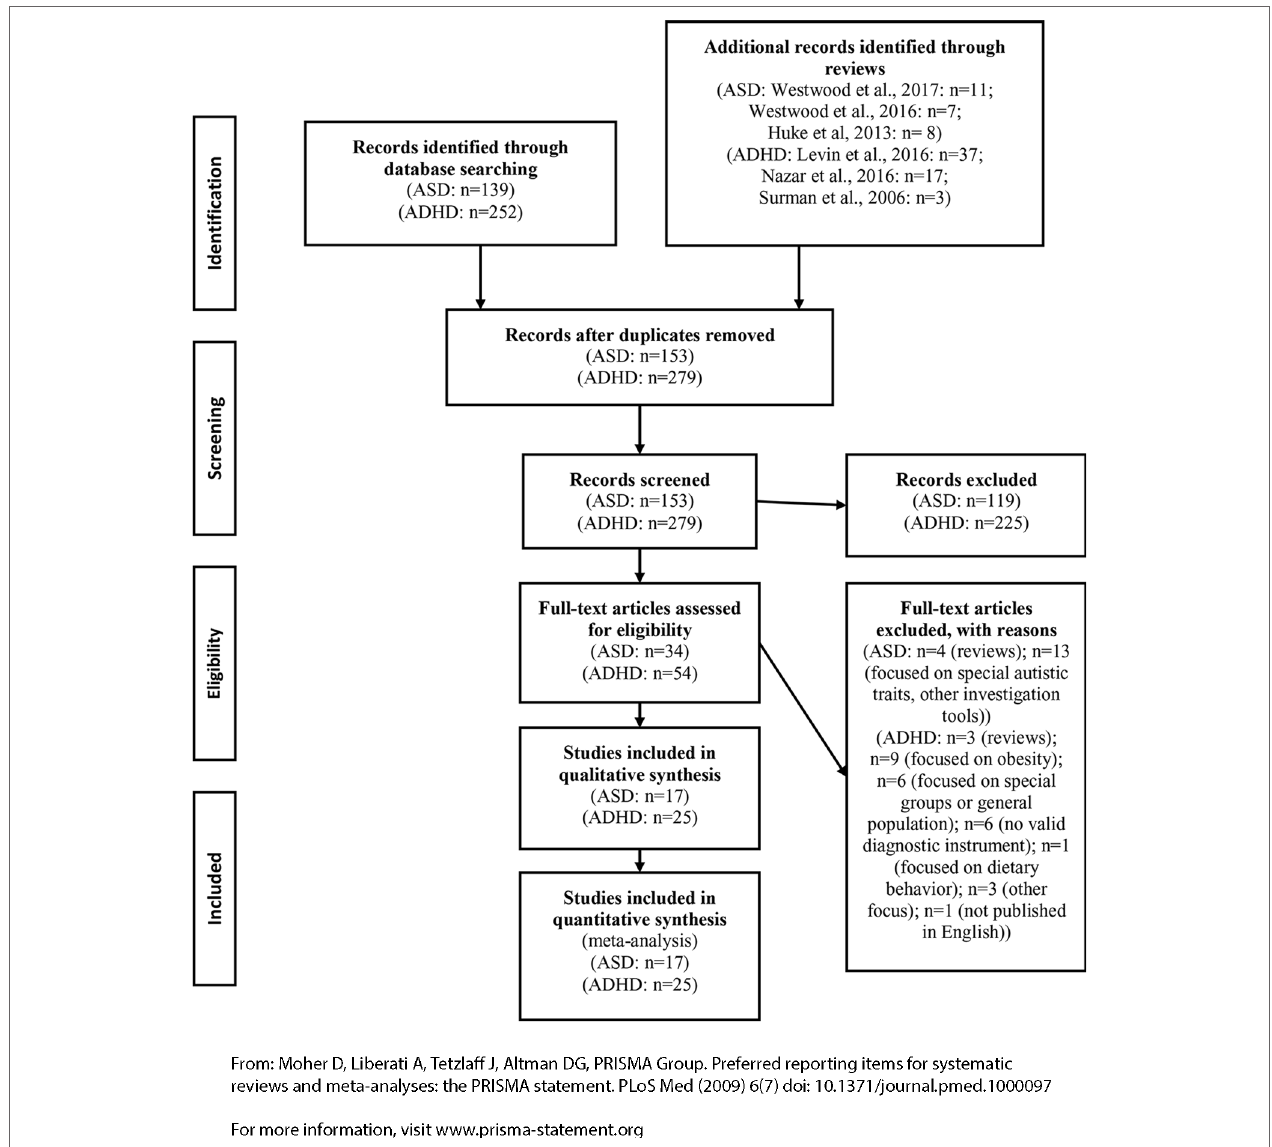
FIGURE 1 | PRISMA flow diagram (selection of studies ASD in EDs, ADHD in EDs, and vice